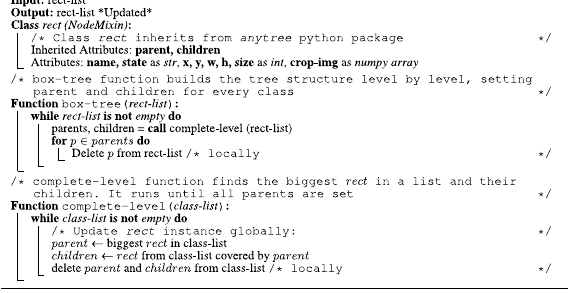
Algorithm 1: Hierarchy Tree